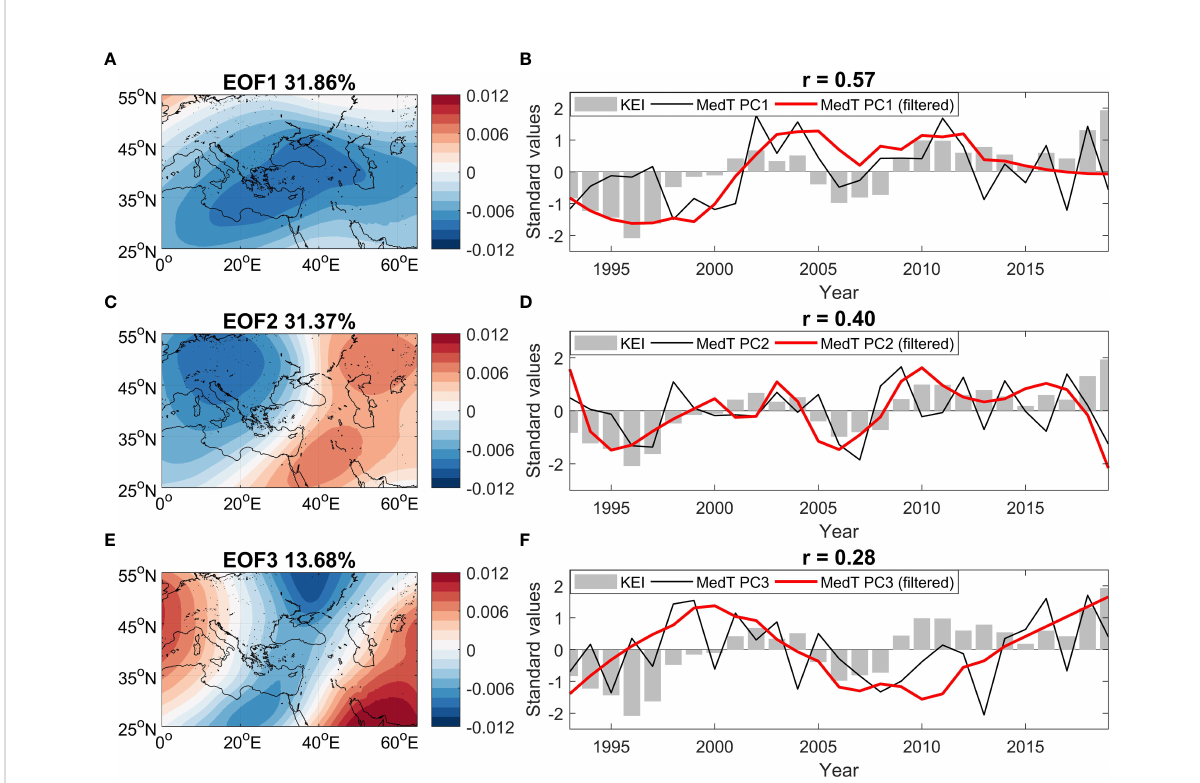
FIGURE 4 (A, C, E) The fi rst three dominant EOFs at the 500-hPa geopotential height for the MedT region in winter and corresponding variance at the top of each fi gure. (B, D, F) Time series of normalized values for the KEI in OND (gray bar), PC in DJF (black line), and lowpass- fi ltered PC in DJF (red line), with the correlation coef fi cient between KEI and lowpass PC marked on the top of each fi gure. In order to obtain the MedT variation characteristic with the same frequency as the KE, a Savitzky – Golay fi lter with a wind length of 11 years and a degree 2 polynomial is employed to the PC time series for the leading three EOF modes to obtain the lowpass PCs. EOF, empirical orthogonal function; MedT, Mediterranean trough; KEI, Kuroshio Extension index; PC, principal